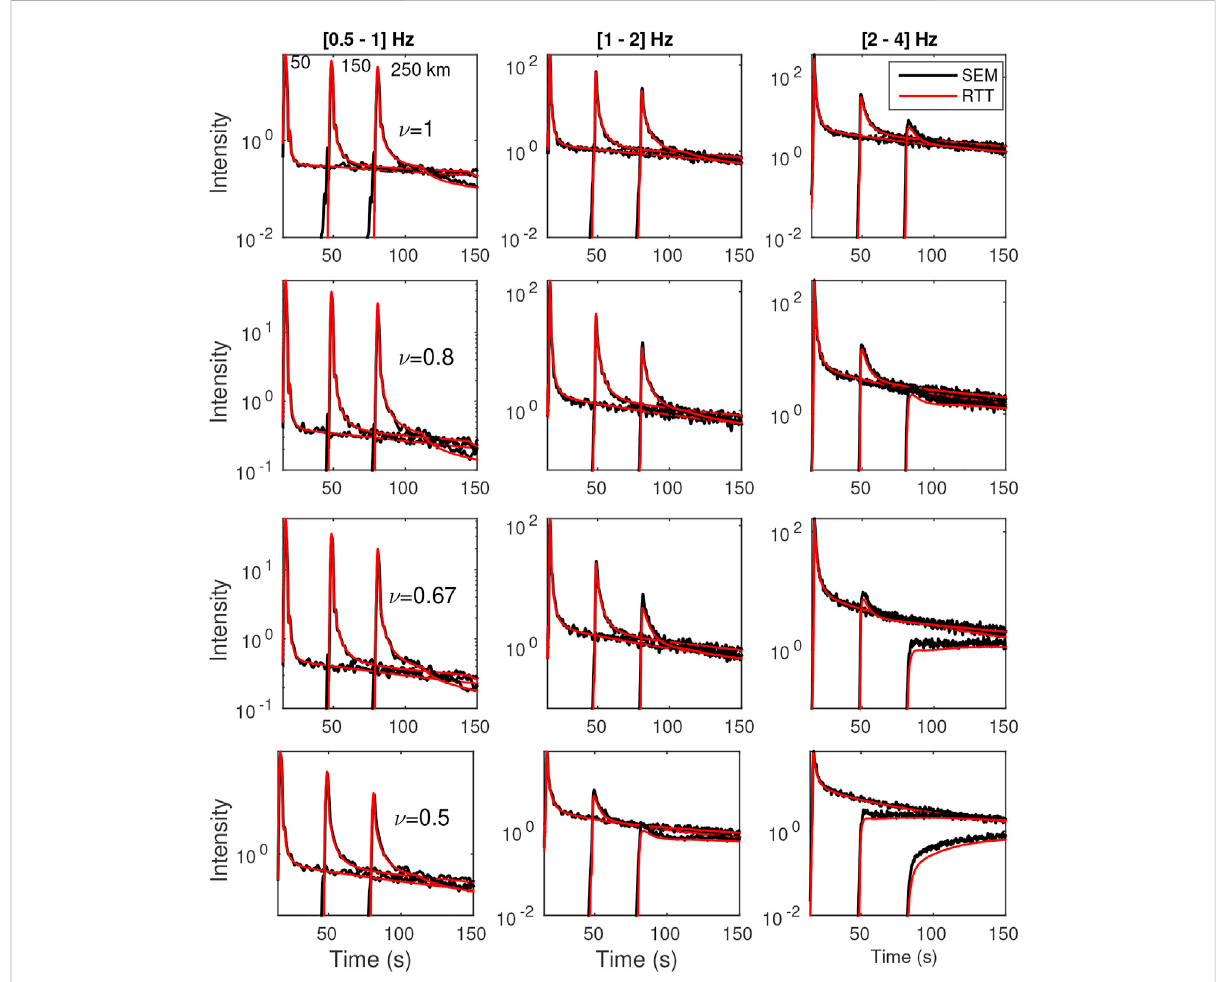
FIGURE 8 MeanintensitycomparisonsbetweenSEMandradiativetransfertheorysolution.Resultsareshownforthreefrequencybands[0.51],[12]and[2 4] Hz, and for three different distances, at 50, 150 and 250 km. Red line corresponds to SEM intensities and the black lines are the radiative transfer theory solution. Cases ε =